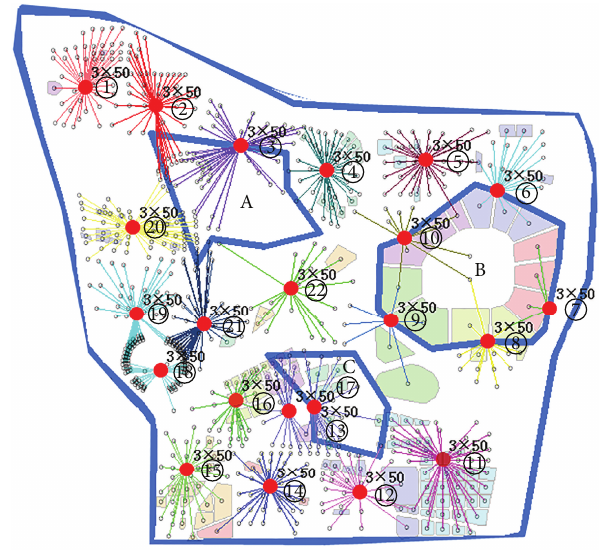
Figure 5: Planning result by the improved WVD.